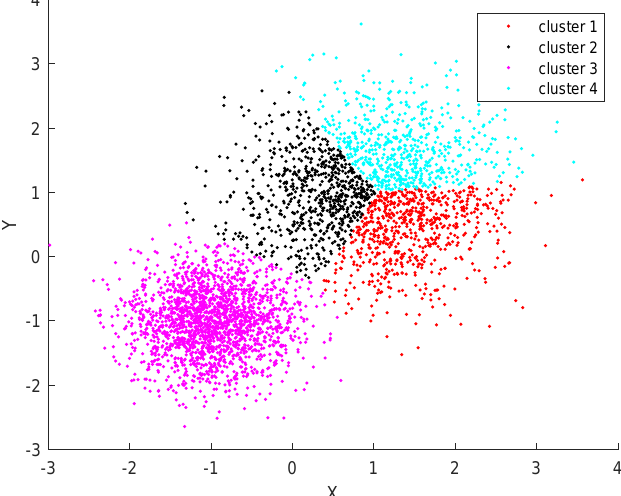
Figure 5. A set of randomly generated samples clustered with the k-means++